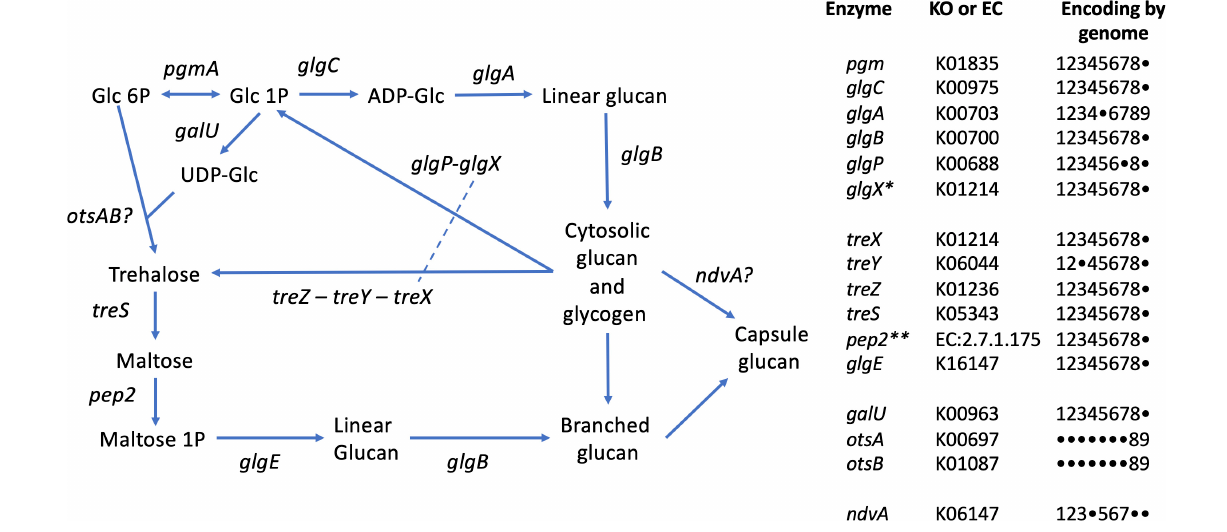
FIGURE 6 | Glycogen and trehalose biosynthetic pathways conserved in members of the genus Defluviicoccus , based on Figure 1 of Chandra et al. (2011). The tabulation on the right lists the enzymes and presence of encoding genes in the 9 genomes analyzed in this study, using the following numeric key: 1: Defluviicoccus vanus ; 2: Ca. Defluviicoccus tetraformis TF071; 3: Ca. Defluviicoccus. sp. SSA4; 4: Ca. Defluviicoccus Fred MAXAC 307; 5: Ca. Defluviicoccus Fred MAXAC 378; 6: Defluviicoccus GAO-HK; 7: Ca. D. seviourii; 8: Ca . Defluviicoccus Kalu MAXAC 148; 9: Defluviicoccu s bin129. A closed circle • denotes genes not identified in the corresponding genome. Full enzyme names as follows: pgm , phosphoglucomutase; glgC , glucose-1-phosphate adenylyltransferase; glgA , glycogen synthase; glgB , 1,4-alpha-glucan branching enzyme; glgP , glycogen phosphorylase; glgX , glycogen debranching enzyme; treX , maltooligosyltrehalose synthase; treY , maltooligosyl trehalose synthase; treZ , malto-oligosyltrehalose trehalohydrolase; treS , trehalose synthase/amylase; pep2 , maltokinase; glgE , alpha-1,4-glucan:maltose-1- phosphate maltosyltransferase; galU , UTP-glucose-1-phosphate uridylyltransferase; otsA , trehalose-6-phosphate synthase; otsB , trehalose-phosphate phosphatase; ndvA , beta-(1– > 2)glucan export ATP-binding/permease protein. ∗ This appears to be a single type of glycogen debranching enzyme in the genus Defluviicoccus; dashed line in pathway schematic. ∗∗ As described by Chandra et al. (2011), in all genomes except D. vanus , pep2 (maltokinase) formed a single continuous sequence with treS and identity was confirmed by sequence alignments; see Supplementary Data File 4